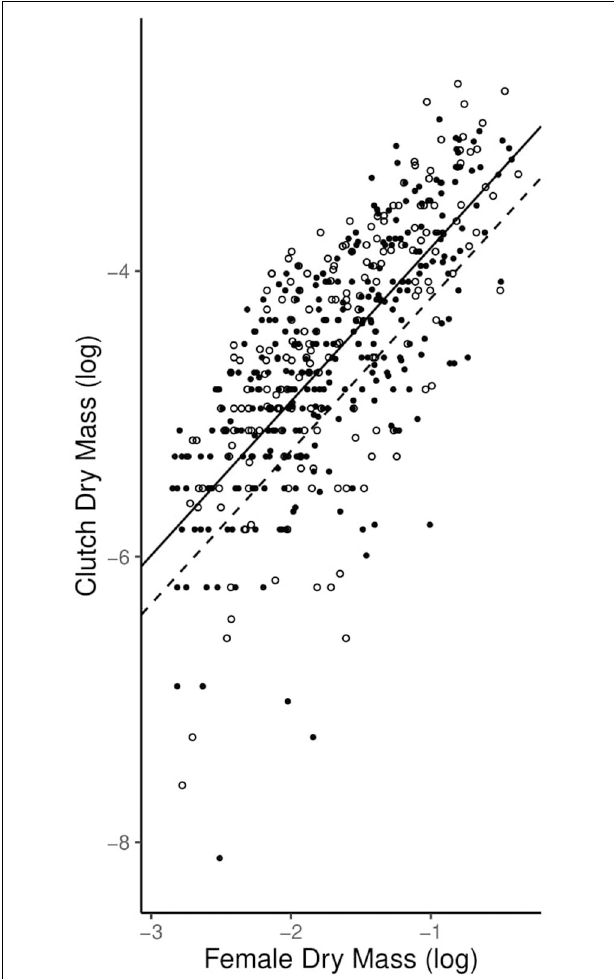
FIGURE 5 | Graph of allometric coefficients for high-predation and low-predation environments. Low-predation sites are open circles and high-predation sites are closed circles. The low-predation allometric coefficient (1.052) is the dashed line and the high-predation allometric coefficient (1.083) is the solid